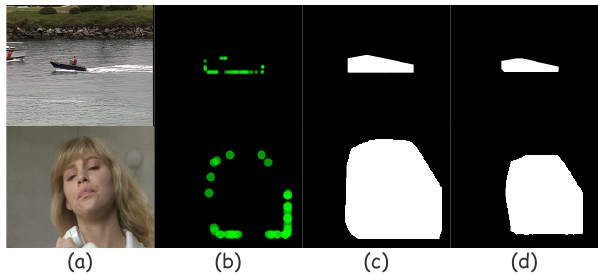
试用限制 Figure 9. Visual effects of mask drawing and mask inflation: ( a ) Raw sequences. (From top to bottom: